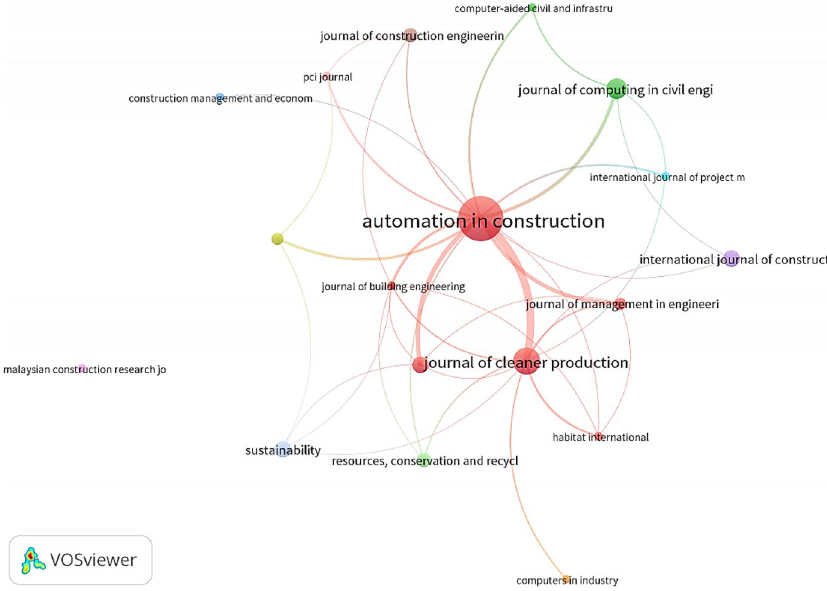
Figure 3. Mapping of influential journals in the research of BIM for PC Table 1. Quantitative measurements of journals’